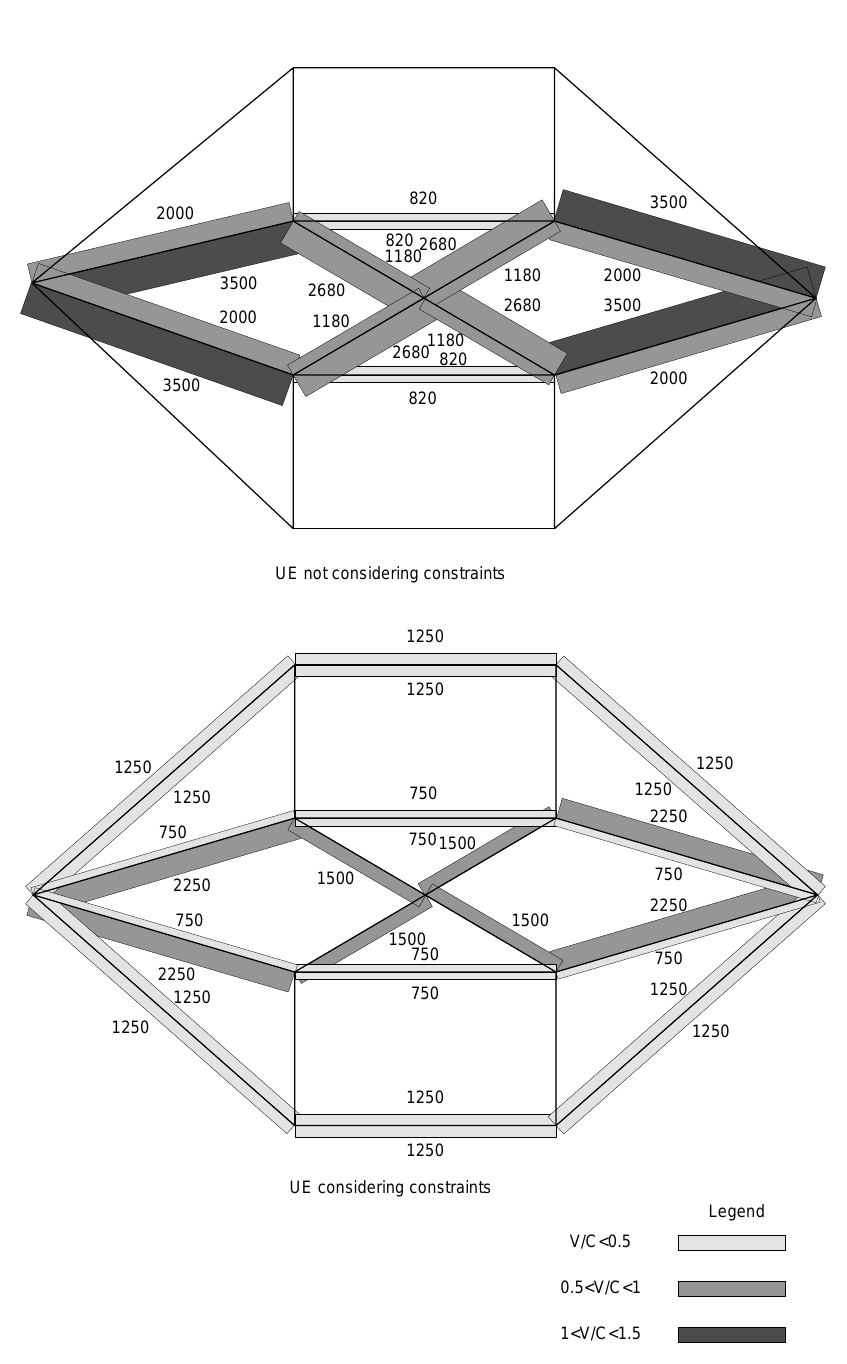
Figure 2. Equilibrium traffic flows with and without capacity